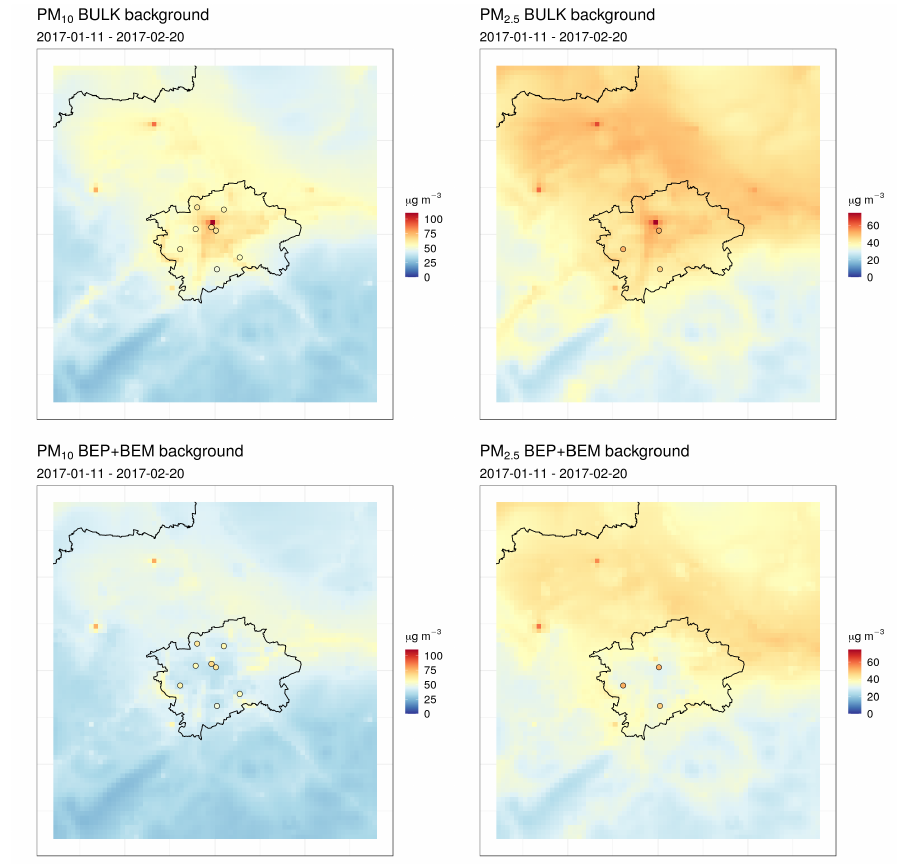
Figure 8. Maps of modeled PM 10 (left) and PM 2.5 (right) concentrations averaged over the entire period with the BULK scheme (top) and BEP+BEM scheme (bottom). Circles represent measurement stations and their average concentrations from the same